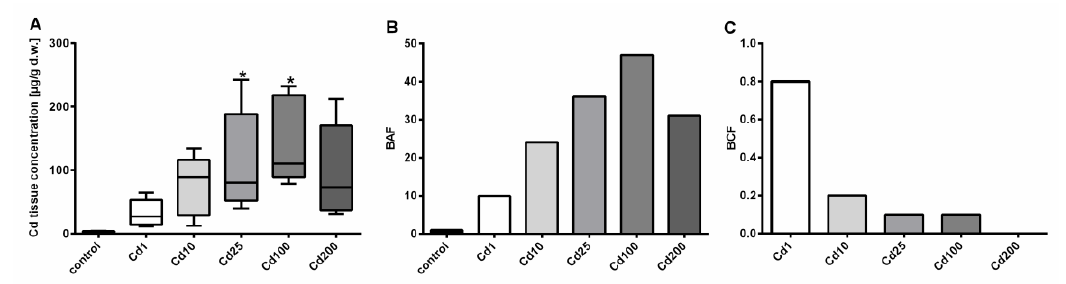
Figure 1. Dose-dependent Cd accumulation in A. biplicata upon Cd exposure through 4 days. ( A ) Whisker box plots showing Cd soft-tissue concentrations in µg/g d.w. of controls ( n = 4) and Cd-treated snails ( n = 5 each) from the lowest to the highest value of each treatment group. The respective box extends from the 25th to the 75th percentile, with the square line showing the median. Asterisks ( * ) indicate significance ( p < 0.05) compared to control value. ( B ) Bar graph showing the bioaccumulation factor (BAF) of respective treatment groups, reflecting the metal accumulation in soft tissues of treated snails, referred to controls (BAF = 1). ( C ) Bar graph representing the bioconcentration factor (BCF; for calculation see Material and Methods) for all Cd exposure groups. The measured Cd concentrations of snail cookies of each treatment group were as follows: Cd1 = 38; Cd10 = 355.3; Cd25 = 804.5; Cd100 = 2692.6; Cd200 = 6396.1 µg/g d.w.